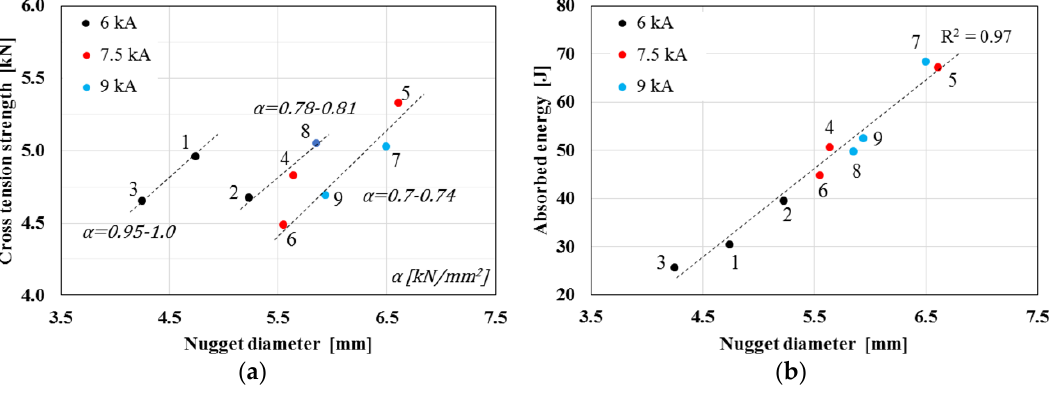
Figure 10. ( a ) cross tension strength and ( b ) absorbed energy of the spot welds for the different welding conditions. The numbers in the graph refer to the experimental runs.